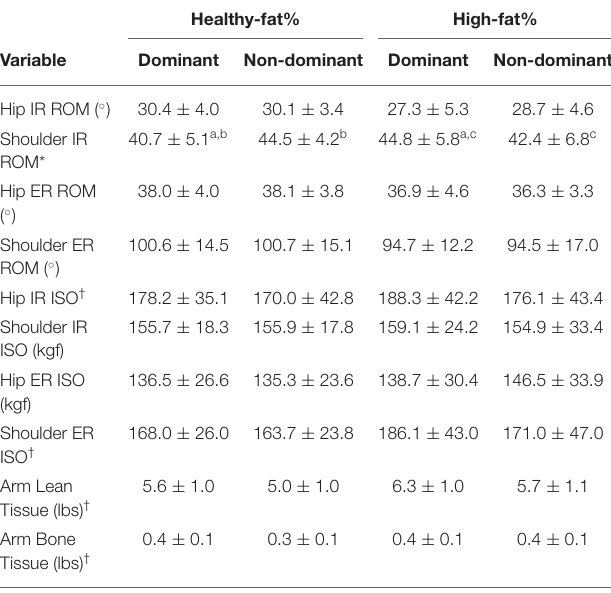
TABLE 1 | Means ± standard deviations for both pitcher groups’ hip and shoulder ISO, ROM, and arm lean tissue and bone. Healthy-fat%